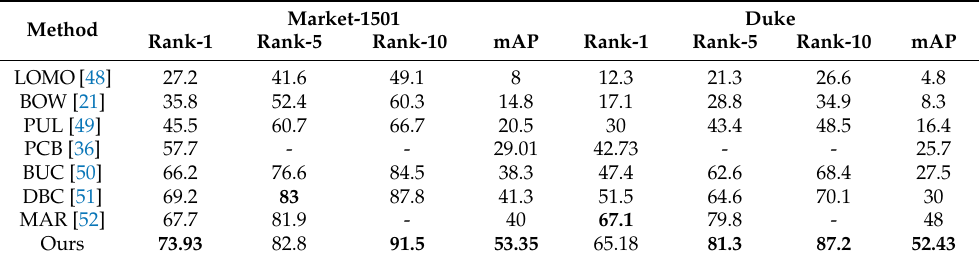
Table 4. Person re-ID performance comparison with the state-of-the-art solutions of unsupervised on Market-1501 and